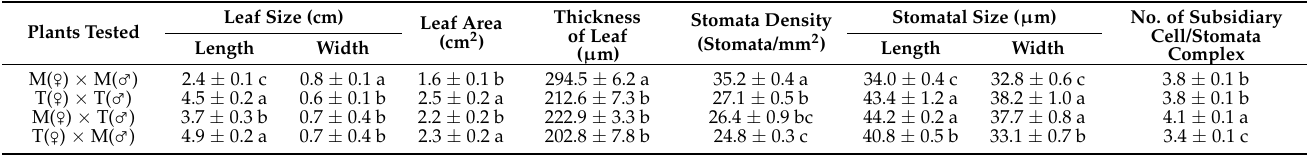
Table 4. Comparison of leaf morphology and anatomy of Phaius hybrids.